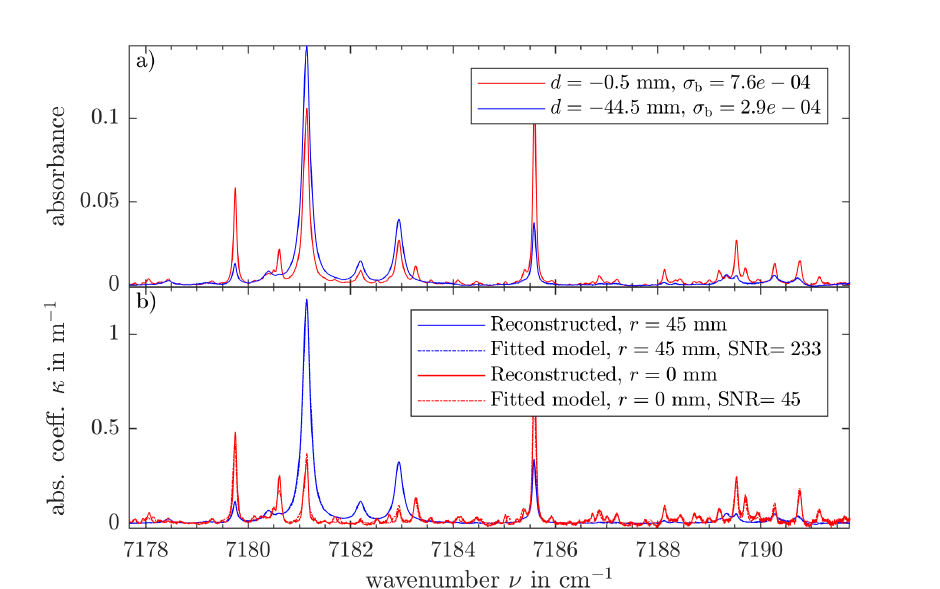
Figure 3. Measured and reconstructed spectra of the Me Air operating point at h = 5 mm. ( a ) measured absorbance spectra for a center beam passing through the flame and an ambient beam at d = − 44.5 mm. ( b ) reconstructed absorption coefficient spectra and their fitted spectroscopic